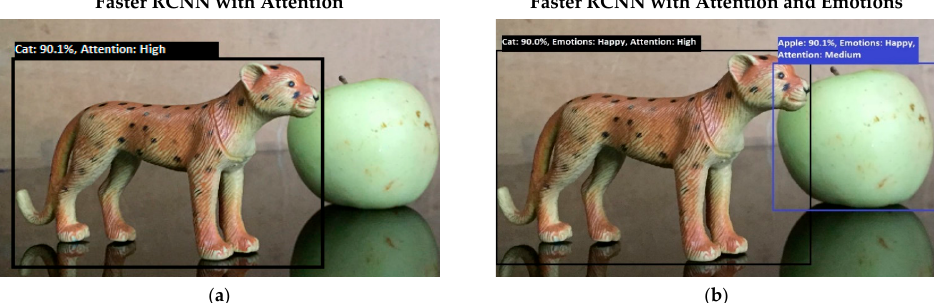
Figure 7. ( a ) This figure shows the recognition of lion and cat objects. Results show that both objects have high attention levels in the bottom-up attention process. ( b ) This figure shows the recognition of lion and cat objects, but the emotions associated with both objects are different. Both emotions fall in a strong emotional state category, but fear emotion has higher intensity, so attention toward a lion is more intensive than it is toward a cat. Figure 7 shows the bottom-up attention regulation under the influence of internal emotions.